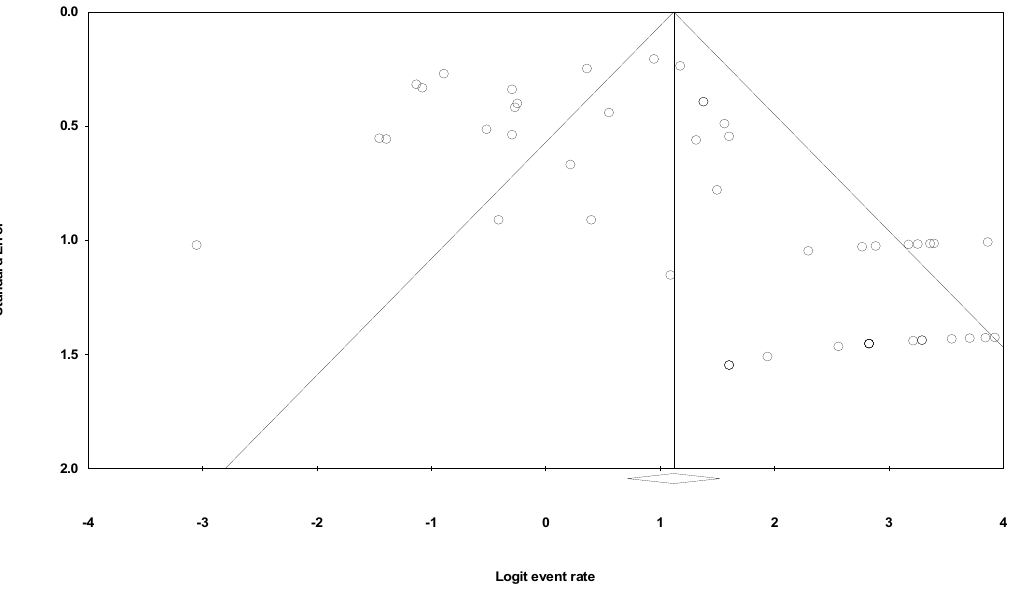
Figure 4. Funnel plot showing the evidence of publication bias.